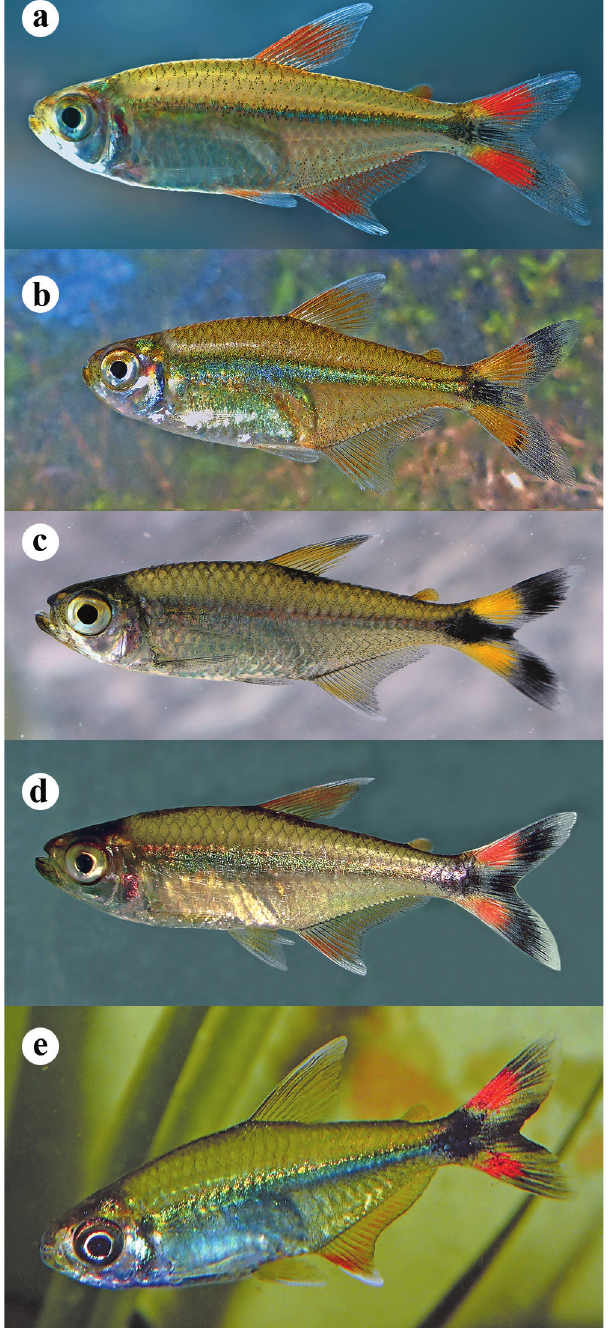
Fig. 5. Coloration pattern in live of Moenkhausia bonita from different geographic basins. a. CI-FML 7272, unnamed stream between Blanco and Bermejo rivers, Salta, Argentina (by Felipe Alonso); b. CI-FML 5351, El Oculto stream, Bermejo basin, Orán, Salta, Argentina (by Felipe Alonso); c. uncatalogued specimen, Lagoon or Bahia in BR362 next to rio Paraguay in Corumbá, Brazil; d. uncatalogued specimen, Mburucuyá National Park, Paraná basin, Corrientes, Argentina (by Liliana Ciotek); e. uncatalogued specimen, Lagoon at rio Riachuelo, Paraná basin, San Luis del Palmar, Argentina (by Miguel Albarenga).